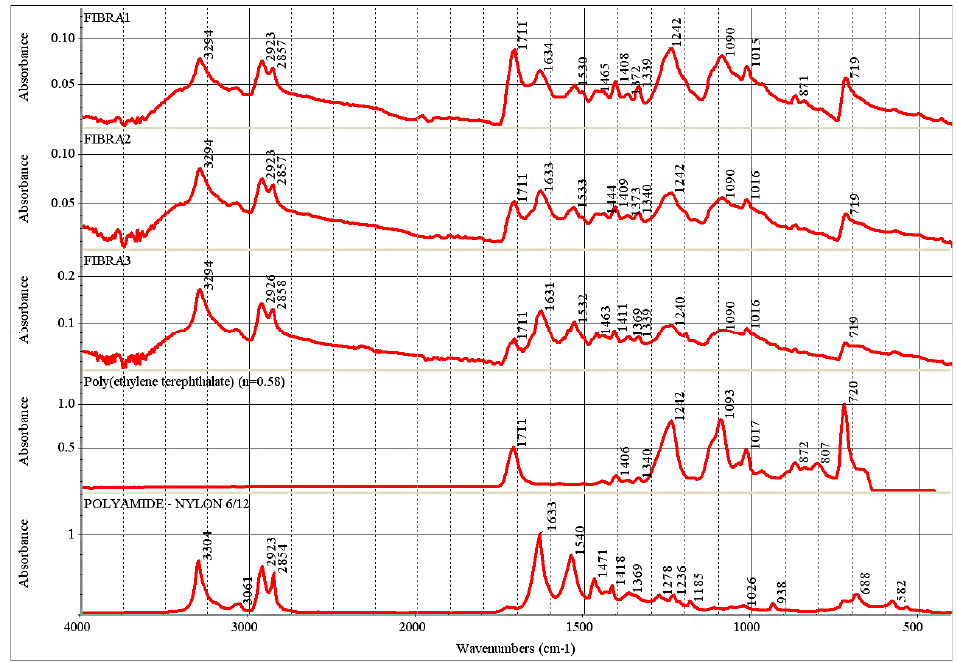
Figure 5. FTIR spectra of the treated recycled tyre polymer fiber.